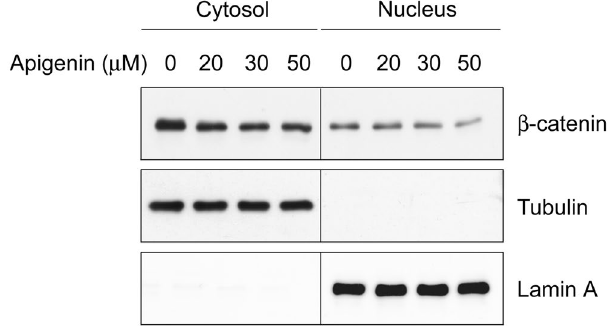
Figure 5. Apigenin decreases the protein levels of cytoplasmic and nuclear β -catenin. HCT-116 cells were treated with different concentrations of apigenin (0, 20, 30, 50 μ M) for 22 h. Cells were collected for the isolation of cytosol and nuclear fractions as described in methods. Cytosolic and nuclear lysates were subjected to Western blotting analyses with anti- β -catenin, anti-tubulin, and anti-lamin A. Tubulin served as the cytosolic marker and lamin A served as the nuclear